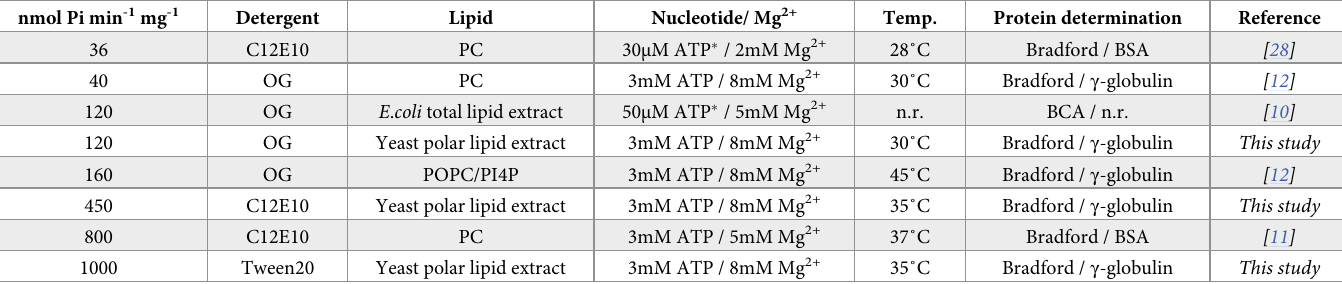
Table 1. Specific activities reported in nmol/min/mg for purified and lipid/detergent reactivated Spf1p with the conditions for individual experiments shown. Star indicate activity measurements using radiolabeled ATP 32 , C12E10: Polyoxyethylene(10)dodecyl Ether, OG: n-Octyl- β -D-Glucopyranoside, PC/POPC: phosphatidylcholine and n.r.: not reported. For comparison polyamine stimulated activity of lipid activated ATP13A2 is ~150 nmol/min/mg [2] and for Ypk9p ~1.000 nmol/min/mg [18] both at 37˚C, phosphatidylserine stimulated activity of the lipid flippase ATP8A1 is ~100.000 nmol/min/mg at 37˚C [36], the activated state of the Pma1p H + ATPase is reported at ~12.000 nmol/min/mg at 30˚C [37] and activity for SERCA and SPCA Ca 2+ ATPases are reported at ~12.000 nmol/min/mg and ~2500 nmol/min/mg respectively in proteoliposomes [38].